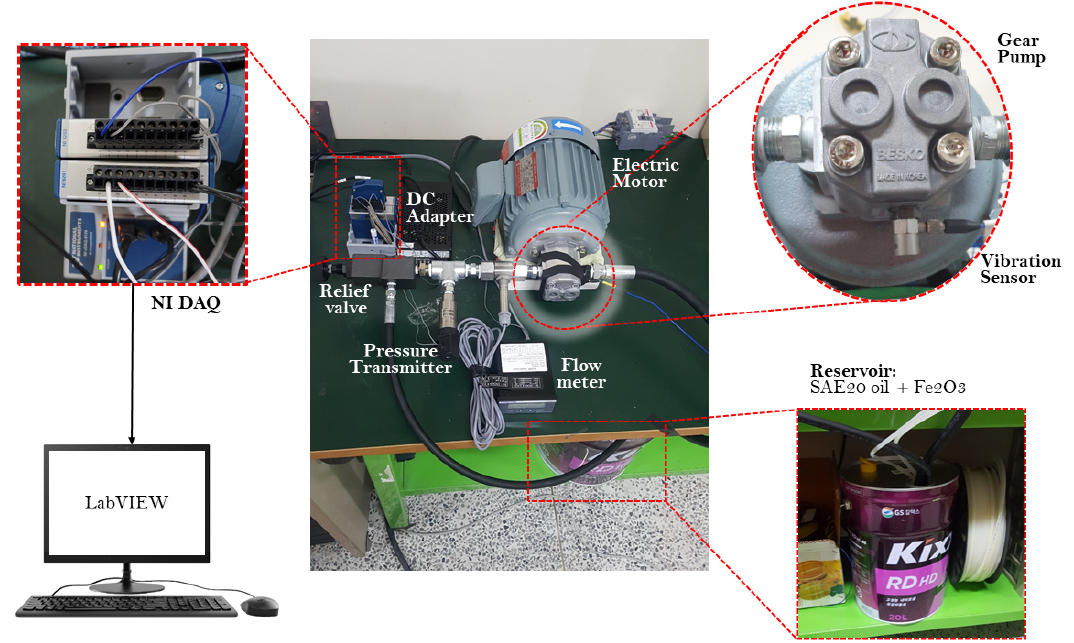
Figure 9. Diagram showing the experimental setup and and data collection